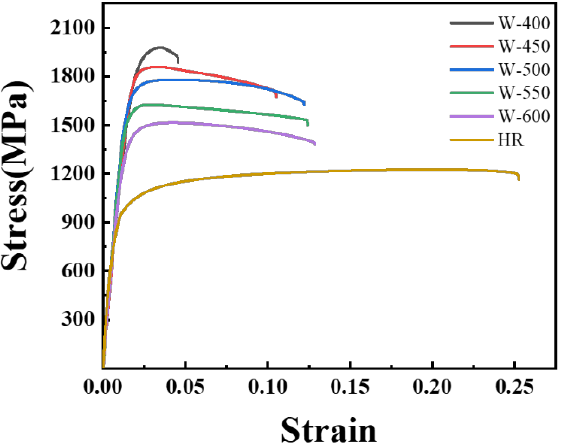
Figure 7. Engineering stress–strain curve of multilayer composite steel. Table 3. Tensile properties of 18Mn/40Si2CrMo multilayer composite steel with different warm roll- ing temperatures.